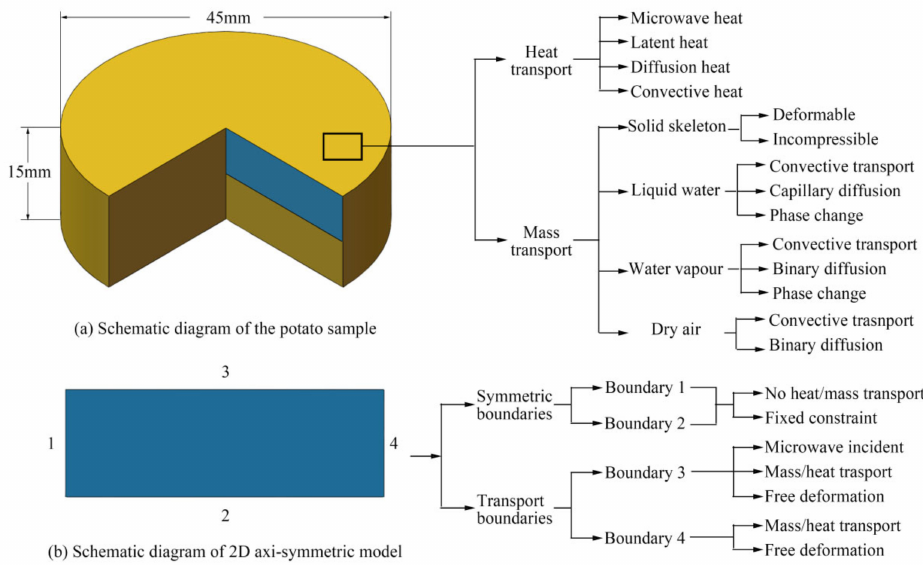
Figure 1. The schematic diagram and the description of the sample. ( a ) The schematic diagram of the potato sample. ( b ) The schematic diagram of 2D axi-symmetric